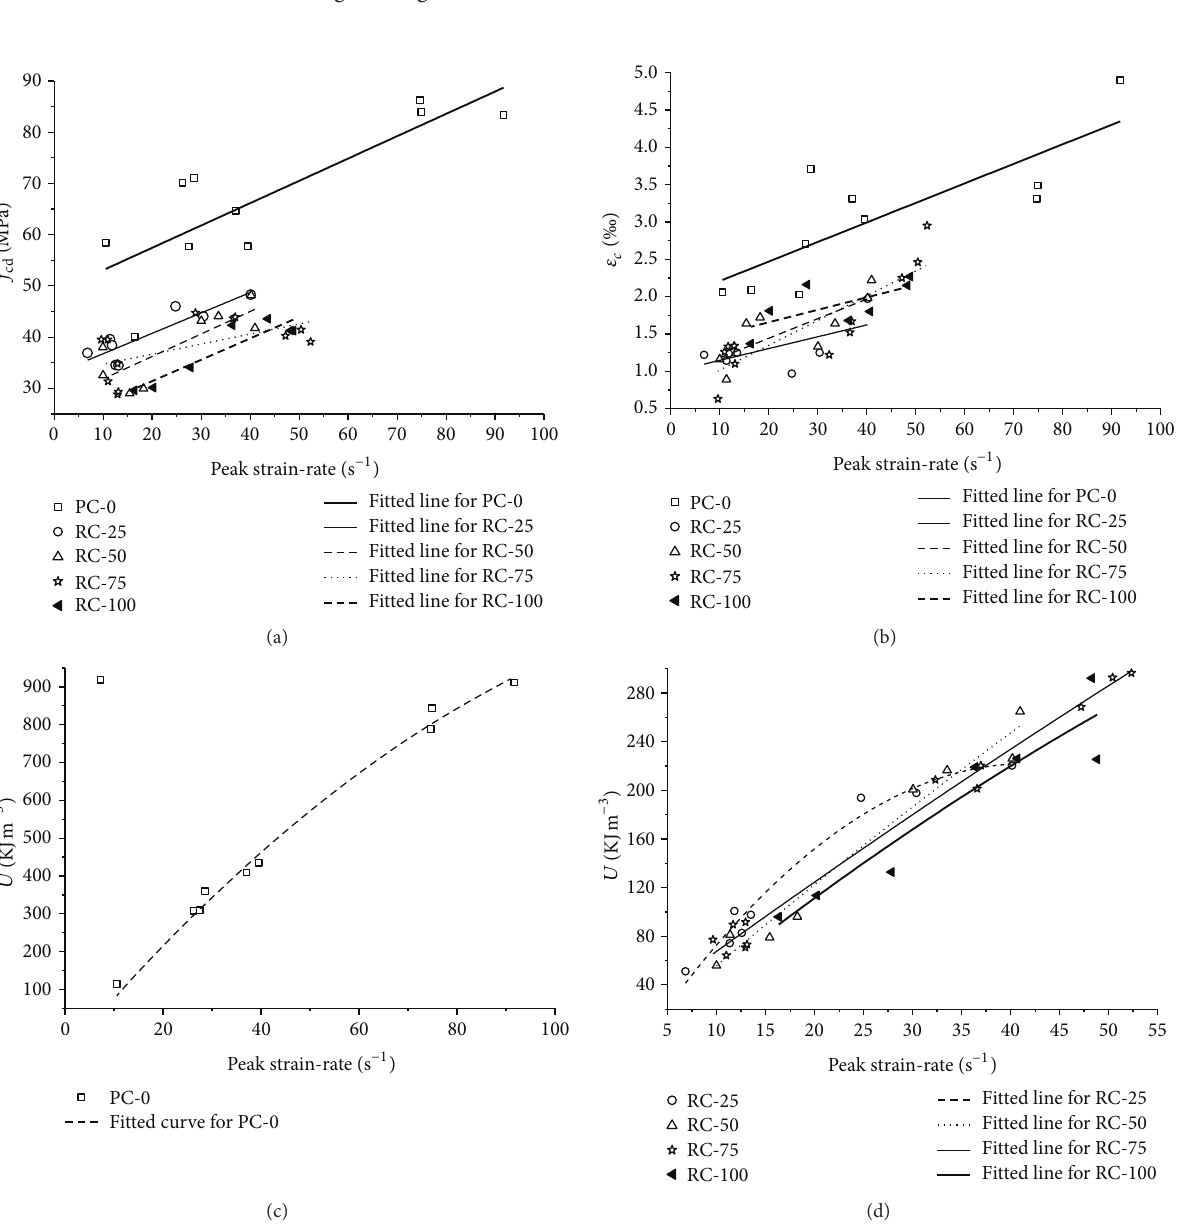
Figure 8: Dynamic compressive strength and critical compressive strain versus peak strain-rate for RAC